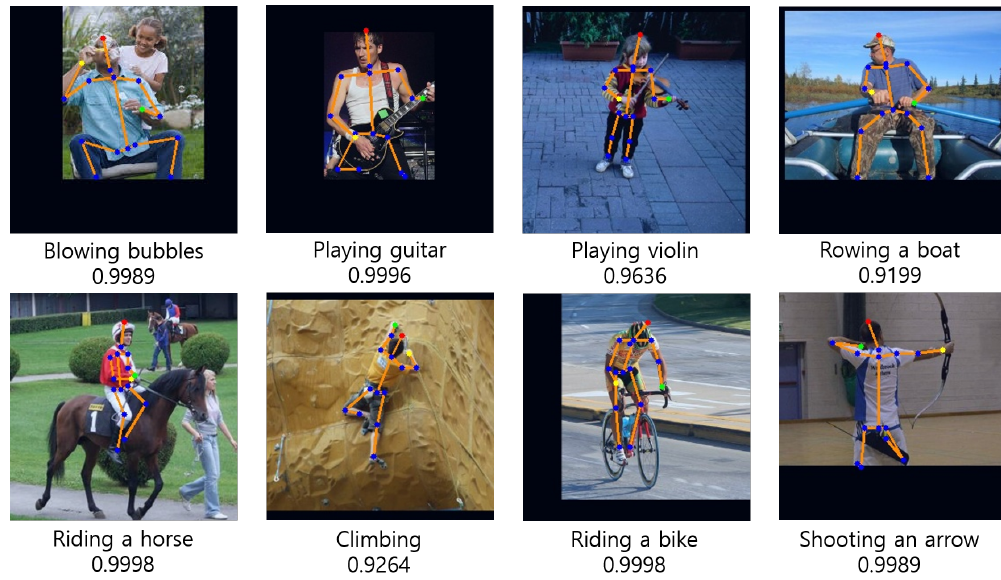
Figure 9. Pose estimation and action recognition results on the Stanford 40 Actions Dataset [15]. Predicted action classes along with confidence scores are shown below the individual